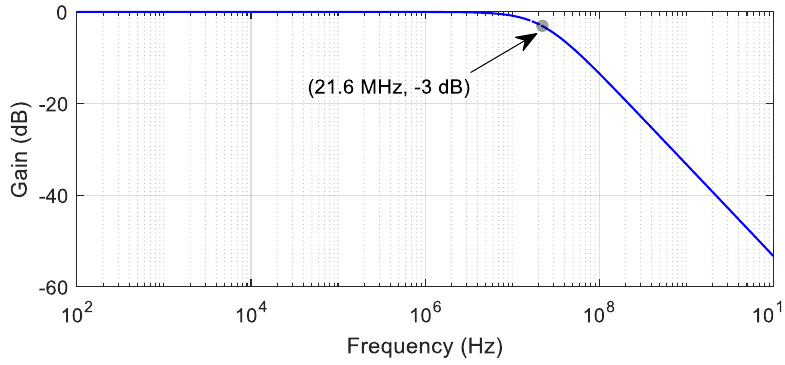
Figure 8. AC transfer characteristics of the coupling device.